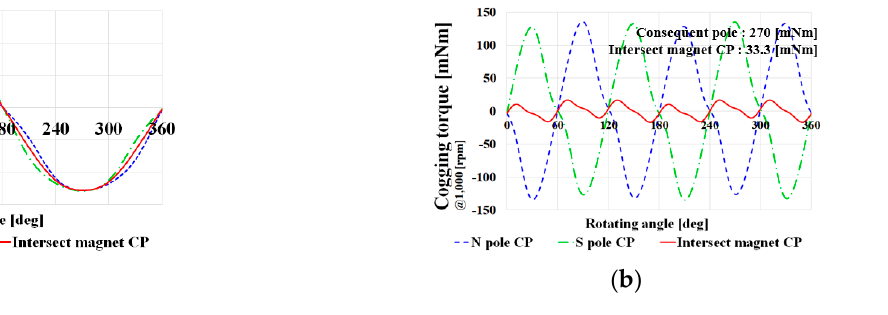
Figure 5. Waveforms of back EMF and cogging torque at N pole CP, S pole CP, and intersect magnet CP (2D simulation result): ( a ) noload back emf, ( b ) cogging torque.